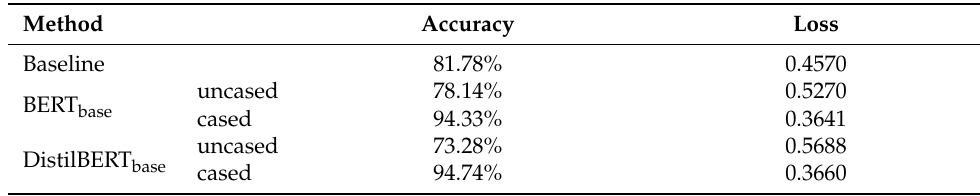
Table 2. The evaluation results.